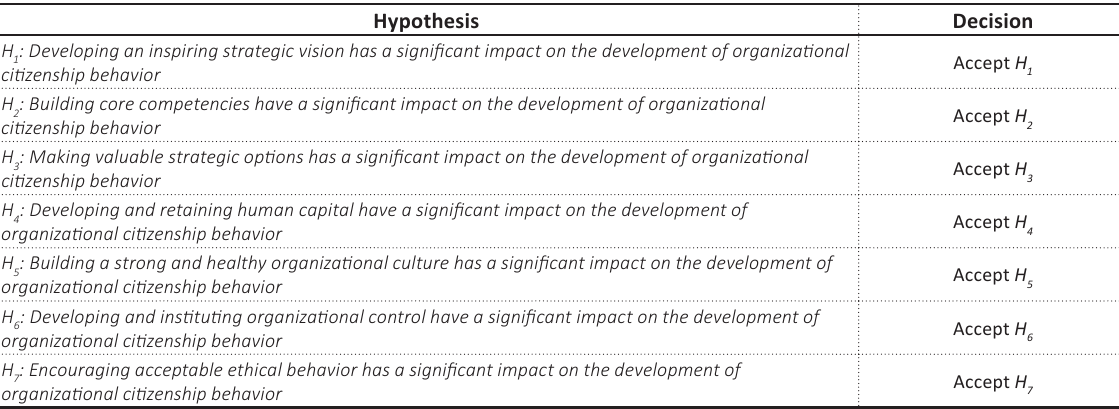
Table 11. Summary of results – hypothesis